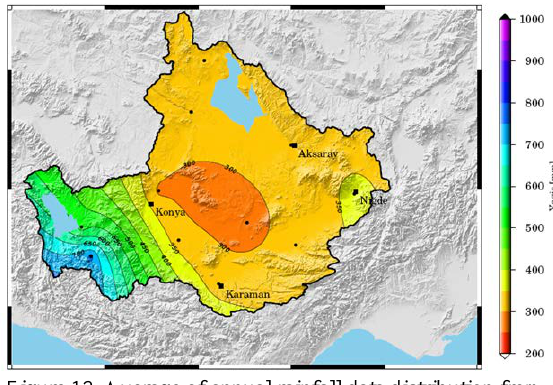
Figure 12. Average of annual rainfall data distribution from 12 meteorological stations over KCB (Ustun, et.al., 2015) The overall area from track 114 as observed by StaMPS PS InSAR shows a similar spatial pattern of subsiding area as are these borders of heavy rainfall data – see Figure 13.